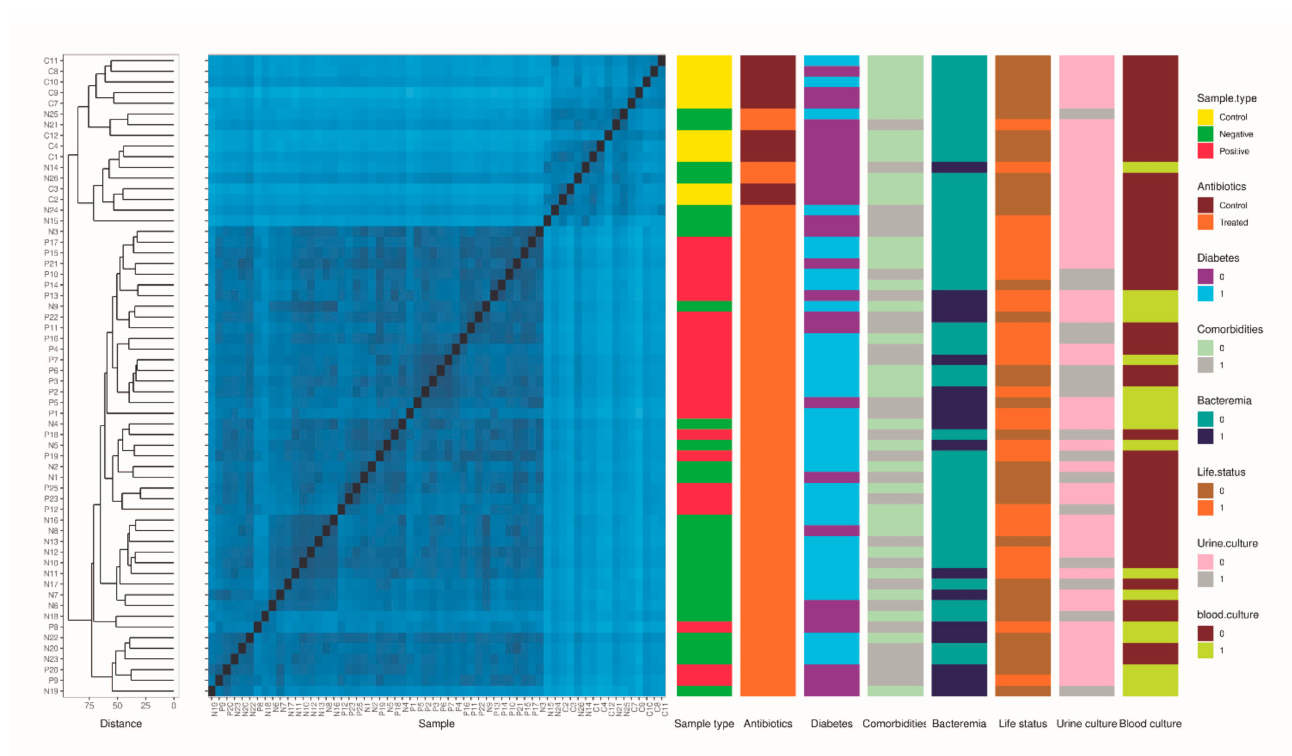
Figure 2. Beta diversity heatmap with hierarchical clustering of individual samples. Aitchison distance was used to hierarchically cluster individual samples using complete